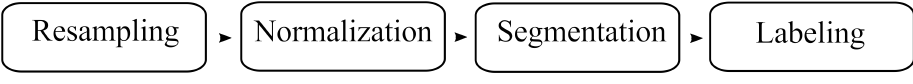
Figure 2. Pre-processing procedure applied on SHRP2 data set for accident